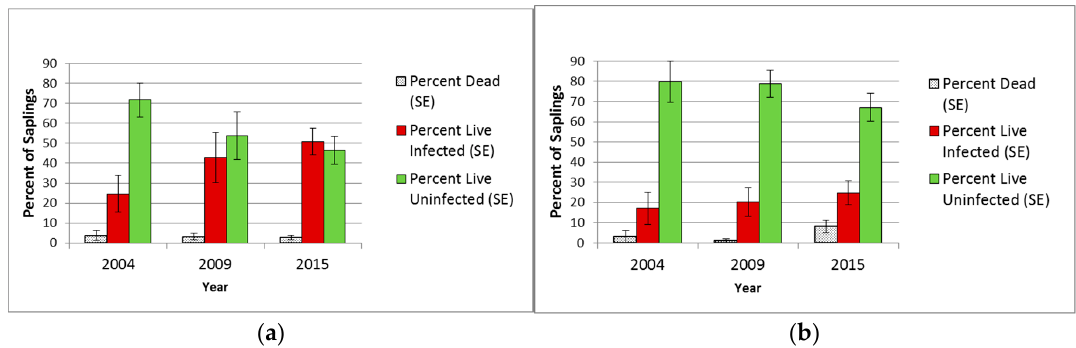
Figure 6. Mean proportions of dead, live infected WPBR, and uninfected whitebark saplings with standard error, in ( a ) Mount Rainier National Park and ( b ) North Cascades National Park Service Complex.